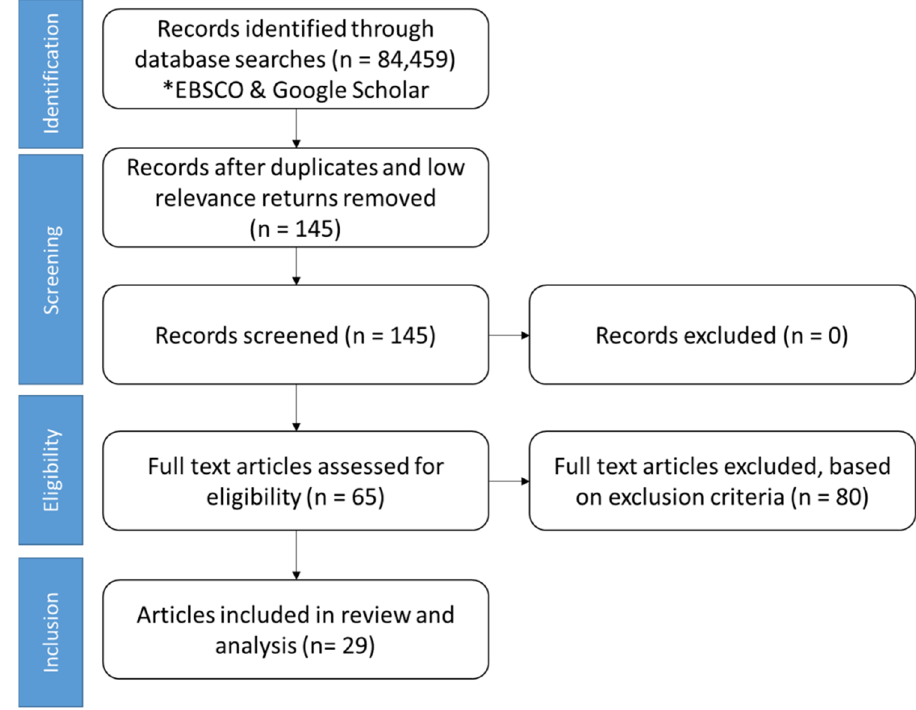
Figure 1. Strategy for literature search using PRISMA guidelines. * Based on literature review criteria search engines. Table 1. Research questions and keyword search terms used in the academic research